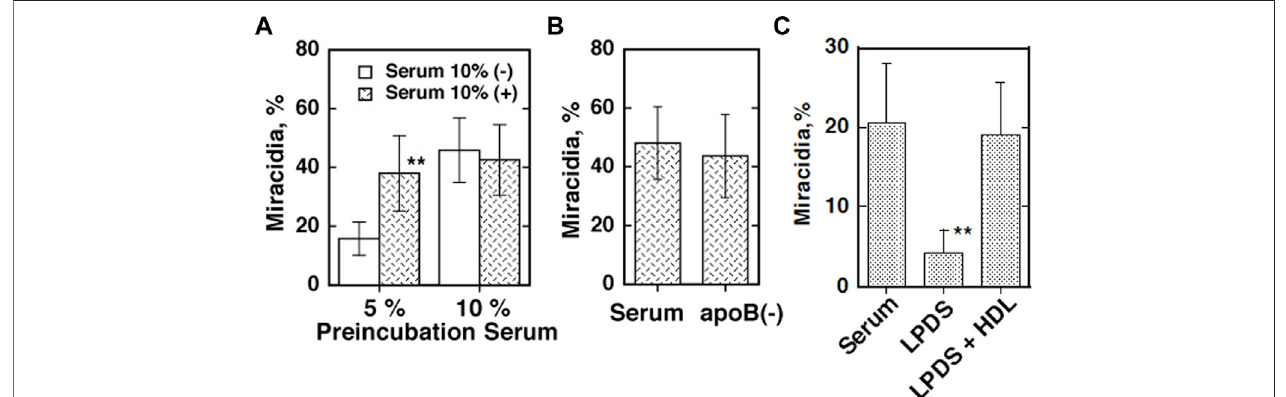
FIGURE 1 | Embryonation/maturation of the S. japonicum eggs in culture (Okumura-Noji et al., 2013). The percentage of miracidia in the total eggs per one pair of the adultparasitescultured for10days wascounted and estimatedasef fi ciency ofembryonation. (A) Theeggs were separated from theadults after 2 days ofculture in the medium containing fi ve or 10% human serum and cultured for 8 days in the fresh media with or without 10% serum. (B) The eggs were removed from the parents culturedin the same conditionas Awith 5%serum and further cultured in 10%ofwhole serum and its d =1.063 bottom fraction [apoB ( − )]. (C) A pair ofthe parent adults wascultured for 10days inthe media with lipoprotein-depleted serum (LPDS) (4 mg protein/ml)withor without isolated HDL fraction (150 μ gcholesterol/ml). The numbers of the adult pairs assayed were 6 (A) and 8 (B,C) . The data represented the average and SE. ** p < 0.005 and * p < 0.05.